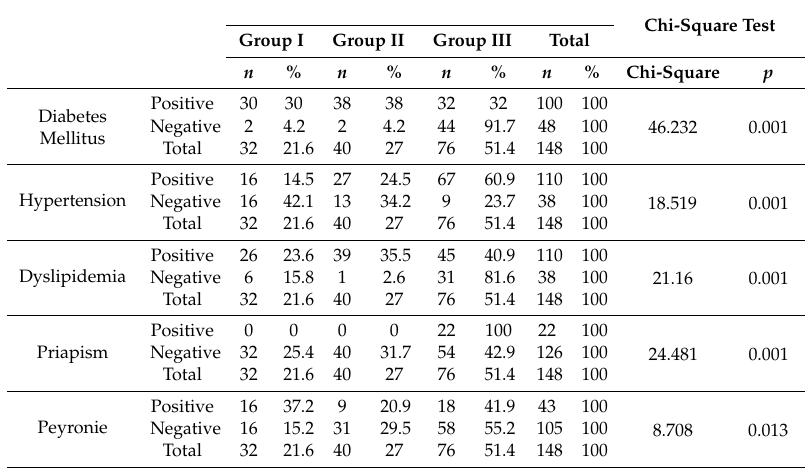
Table 2. Distribution of comorbidities according to the